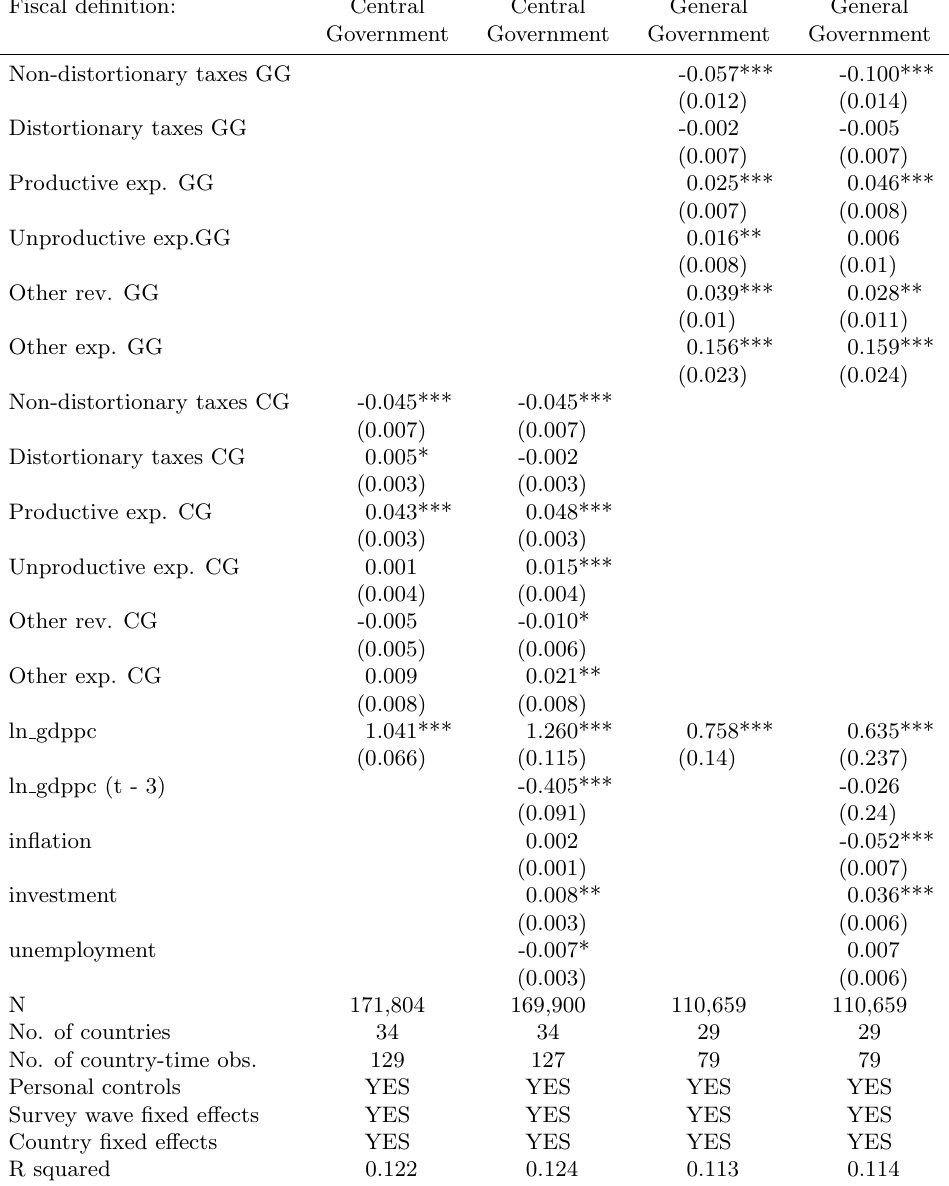
Table A.5: Baseline